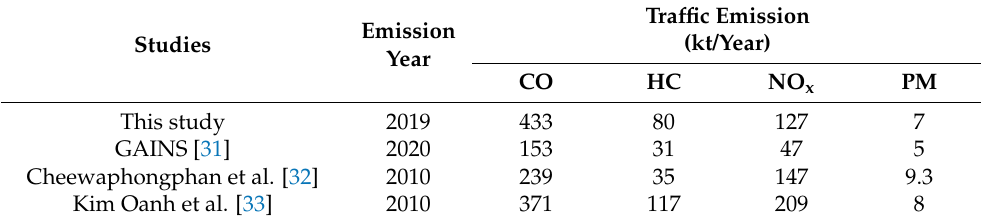
Figure 10. Spatial distribution of PM on different roads in Bangkok. Table 4. Comparison of traffic emission inventories in the BMR